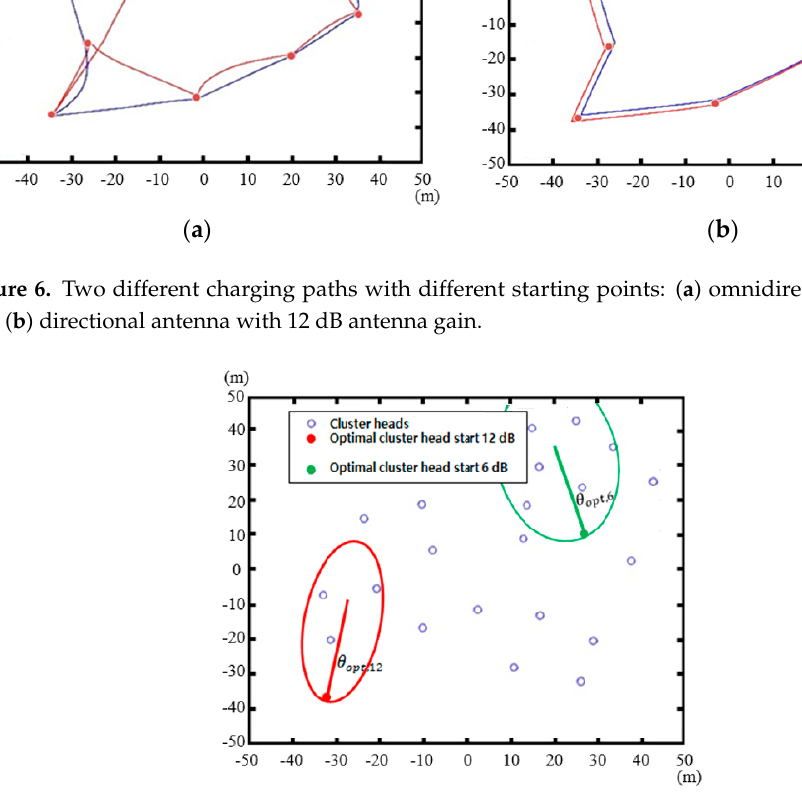
Figure 7. Optimal starting points with different antenna gains. Optimal starting points for directional antennas are often located on the outskirts of the total service area.